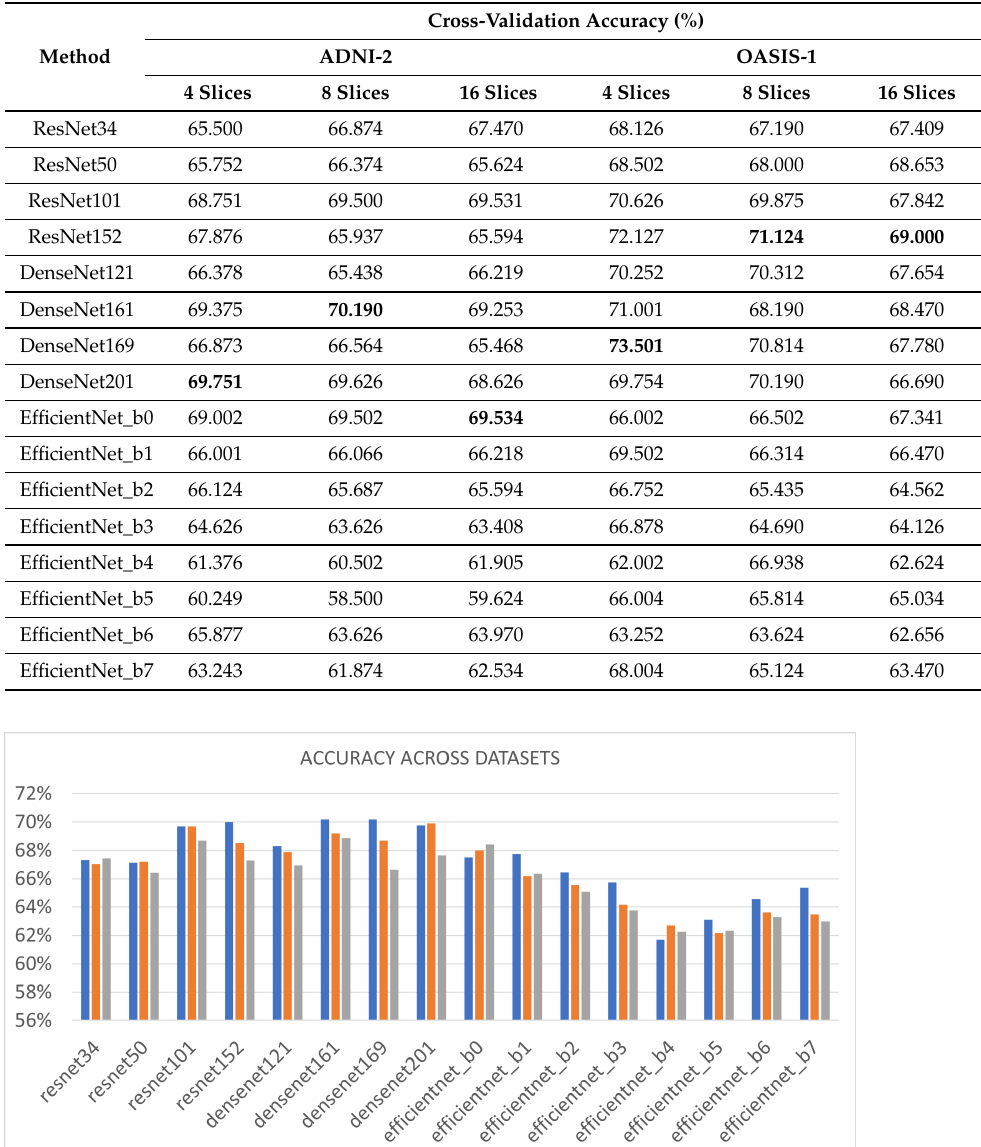
Table 2. AD/NC classification accuracy gathered by CNN. The bold style highlights the best classifi- cation results in each column.